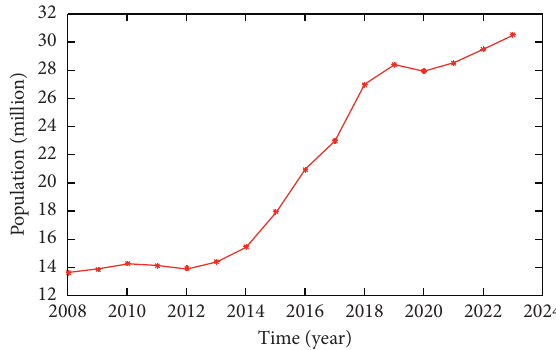
Figure 3: Predicted